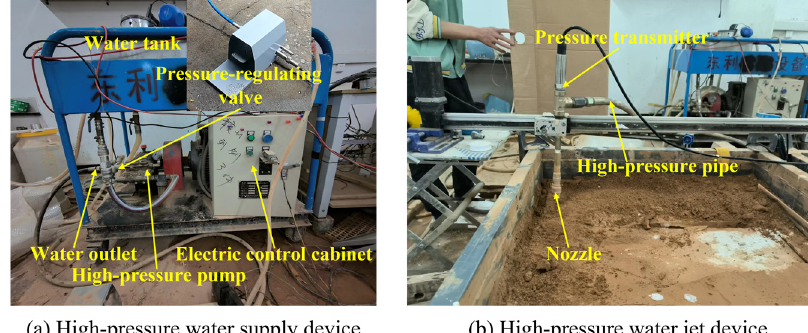
Figure 2. Jet pressure supply module.